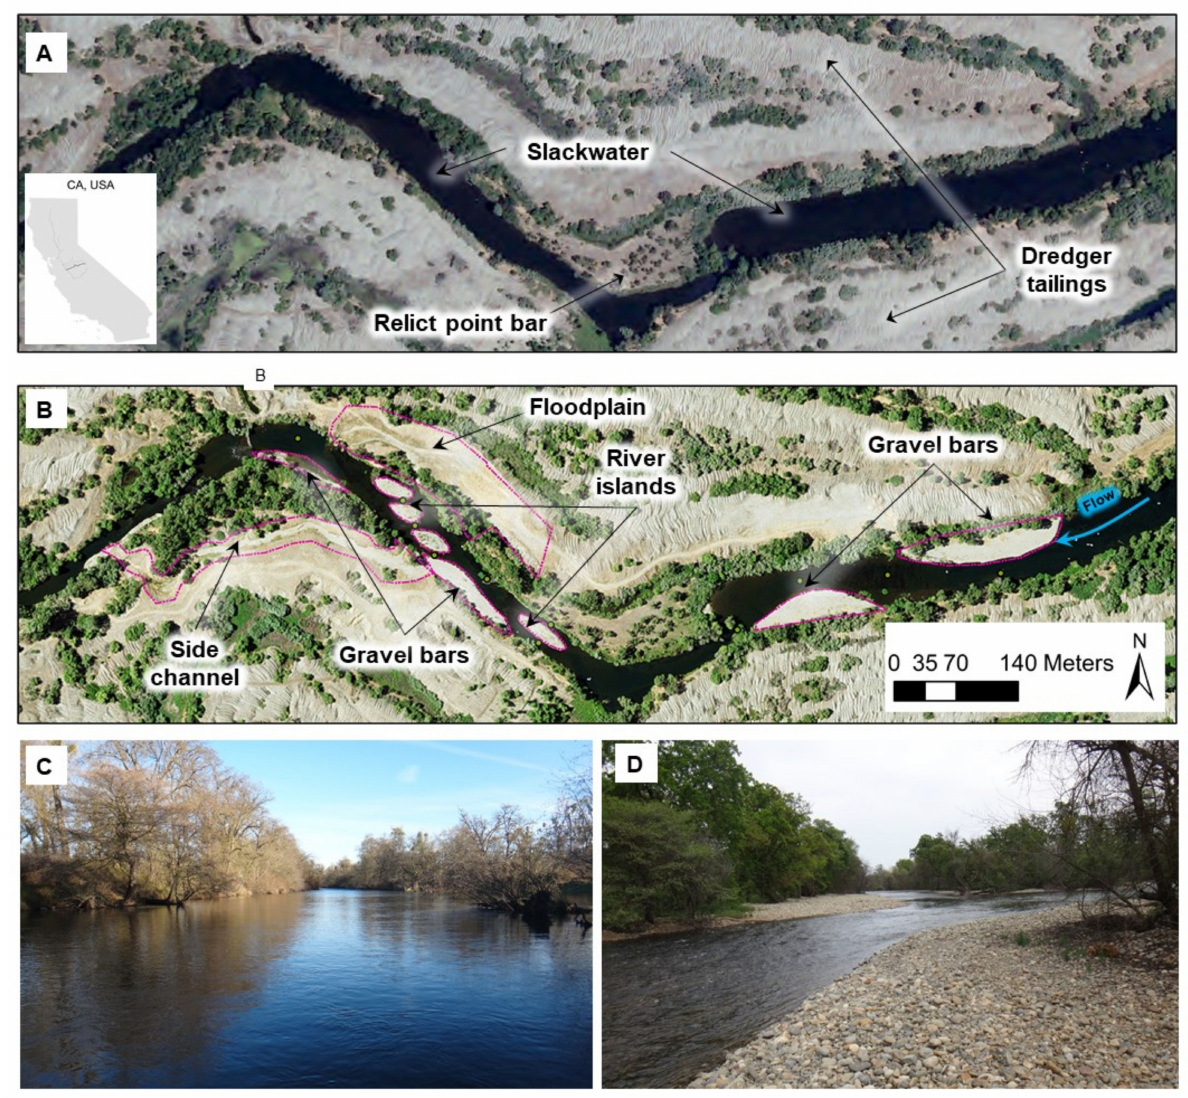
Figure 2. An example habitat restoration project using rescaling on the Merced River California for fall-run Chinook salmon. The setting and basis for this project can be found in [39]. Prior to restoration ( A ), the river channel was confined by dredger mine tailings [39] and channel substrate consisted primarily of cobbles, fine sediment, and non-native aquatic vegetation. The pre-project channel had a bankfull width of approximately twice the predicted value using hydrogeomorphic channel width scaling equations and consisted mostly of slackwater. The restoration approach was to resize the river channel to match the current flow regime as well as restoring off-channel habitat features such as floodplains, side channels, swales, and wetlands by removing dredger tailings. The resized